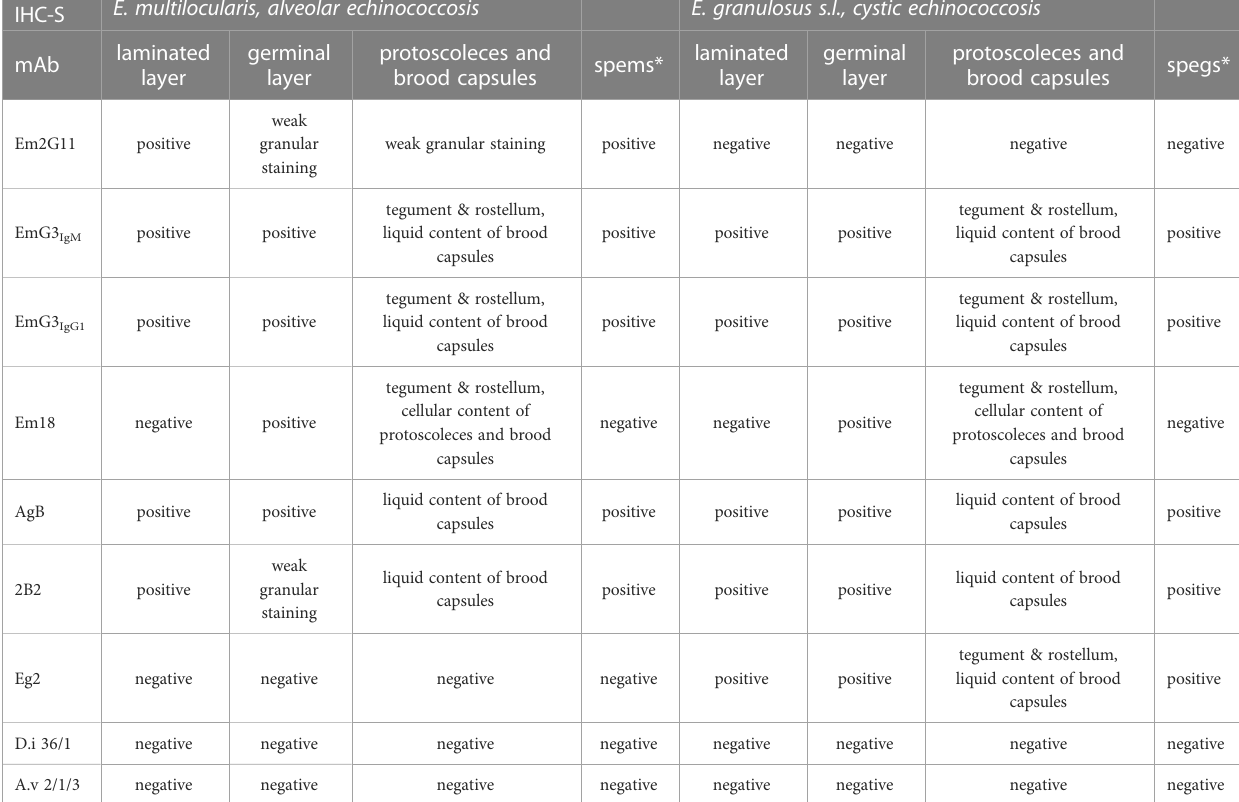
TABLE 3 Immunohistochemical stainings (IHC-S) with mAbs on liver sections of one alveolar- and one cystic echinococcosis patient. IHC-S